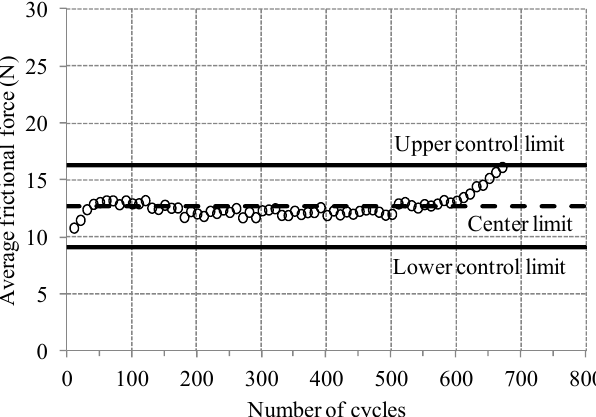
Figure 7. The revised average x -bar chart for the evolution of the average frictional force. Control limits were revised.